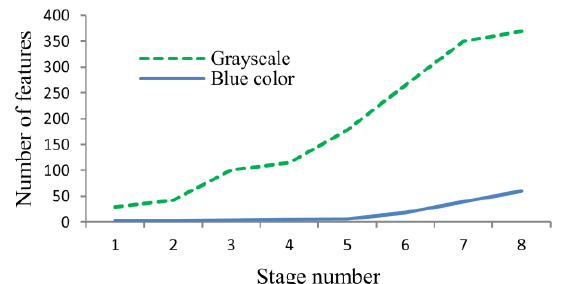
Figure 4: Number of features on the different stages of cascades trained with gray and color features.